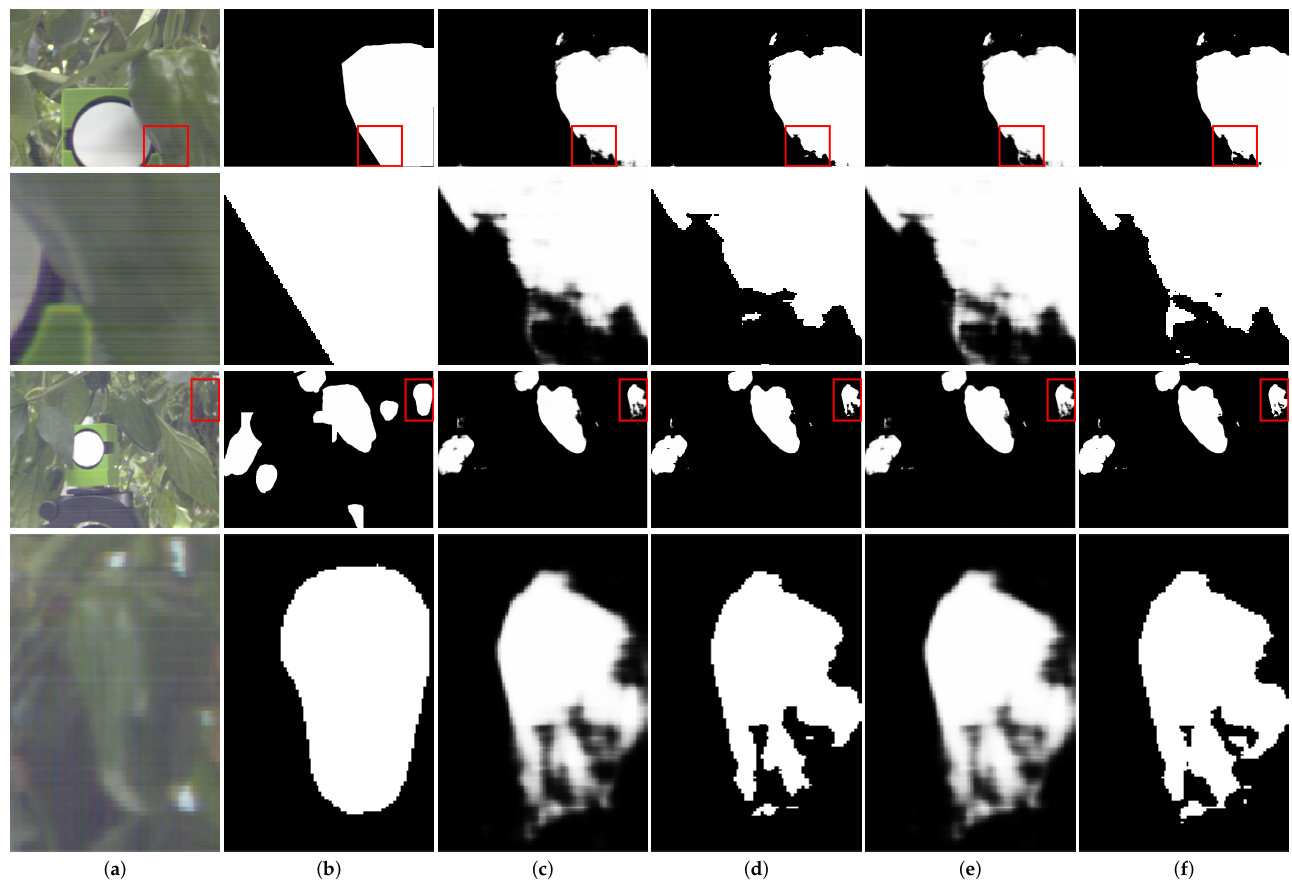
Figure 8. Visual comparison on segmentation results. The red box in rows 1 and 3 are enlarged in rows 2 and 4, respectively. ( a ) The RGB image and relate patch details. ( b ) Ground truth. ( c ) Prediction of simulated Green Pepper Filter. ( d ) Binary prediction of simulated Green Pepper Filter. ( e ) Prediction of merit function 2. ( f ) Binary prediction of merit function 2. Note that our proposed merit function can improve the green pepper segmentation results. Table 2. The evaluation of segmentation result of different